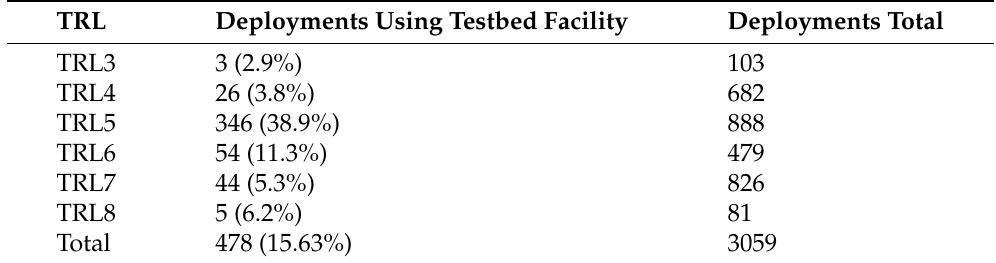
Table 5. Deployment distribution between usage of testbed facilities and technology readiness